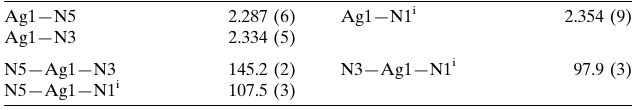
Selected geometric parameters (A˚ , (cid:1)